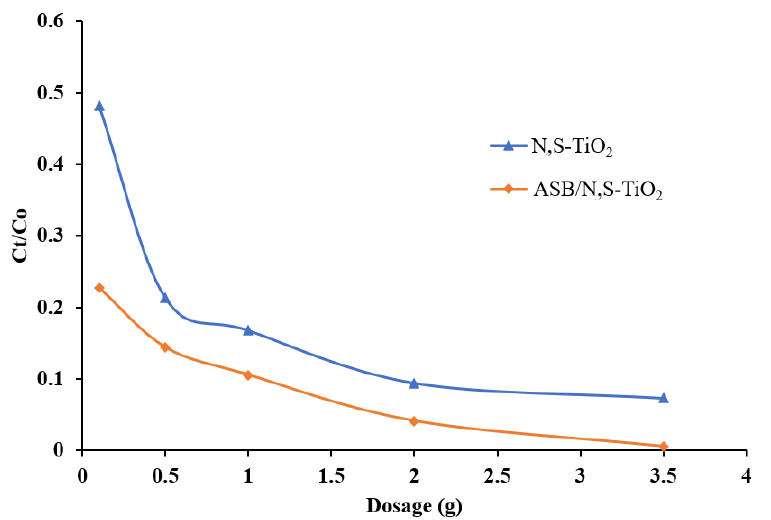
Figure 7. Effect of dosage on removal for N,S-TiO 2 and ASB/N,S-TiO 2 composites (condition: con- tact time = 150 min irradiation, [CIP] 0 = 30 ppm, pH = 5.5–6). time = 150 min irradiation, [CIP] 0 = 30 ppm, pH =